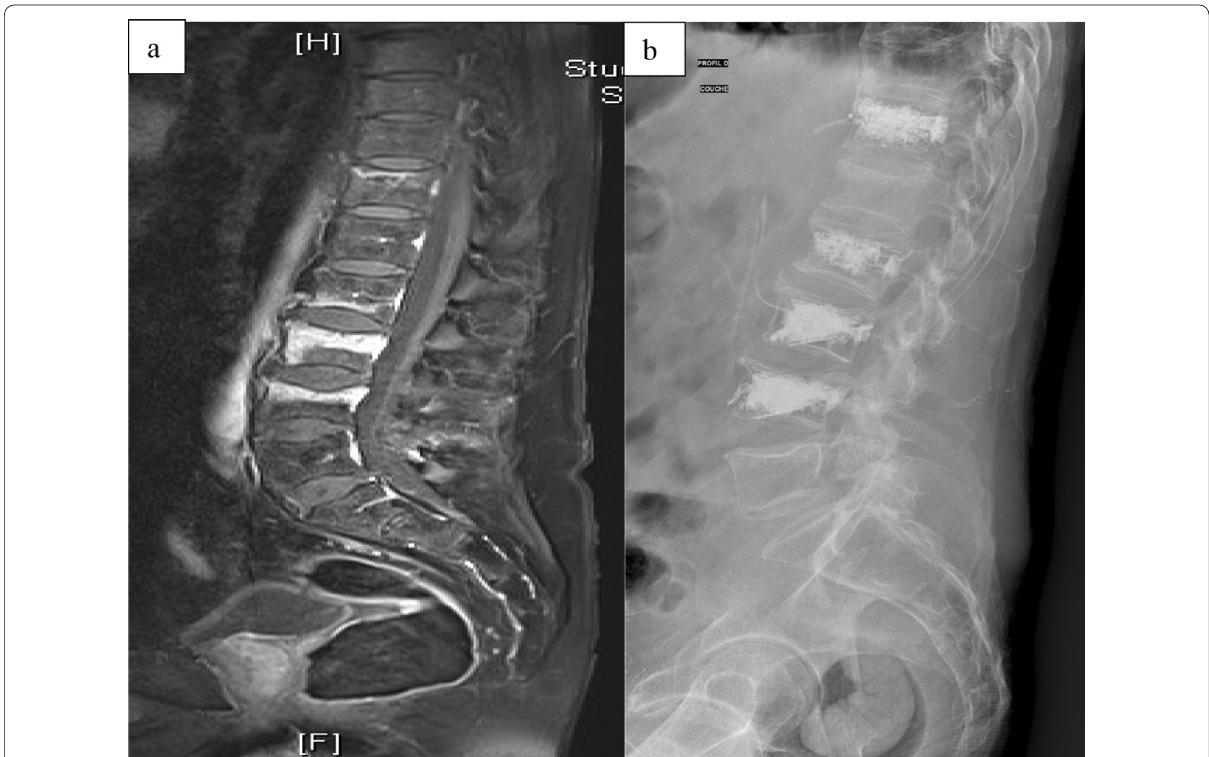
Fig. 3 a MRI, T1 sequence with gadolinium injection of the lumbosacral spine sagittal section: vertebral collapses T12, L2, L3 and L4; b post‑kyphoplasty